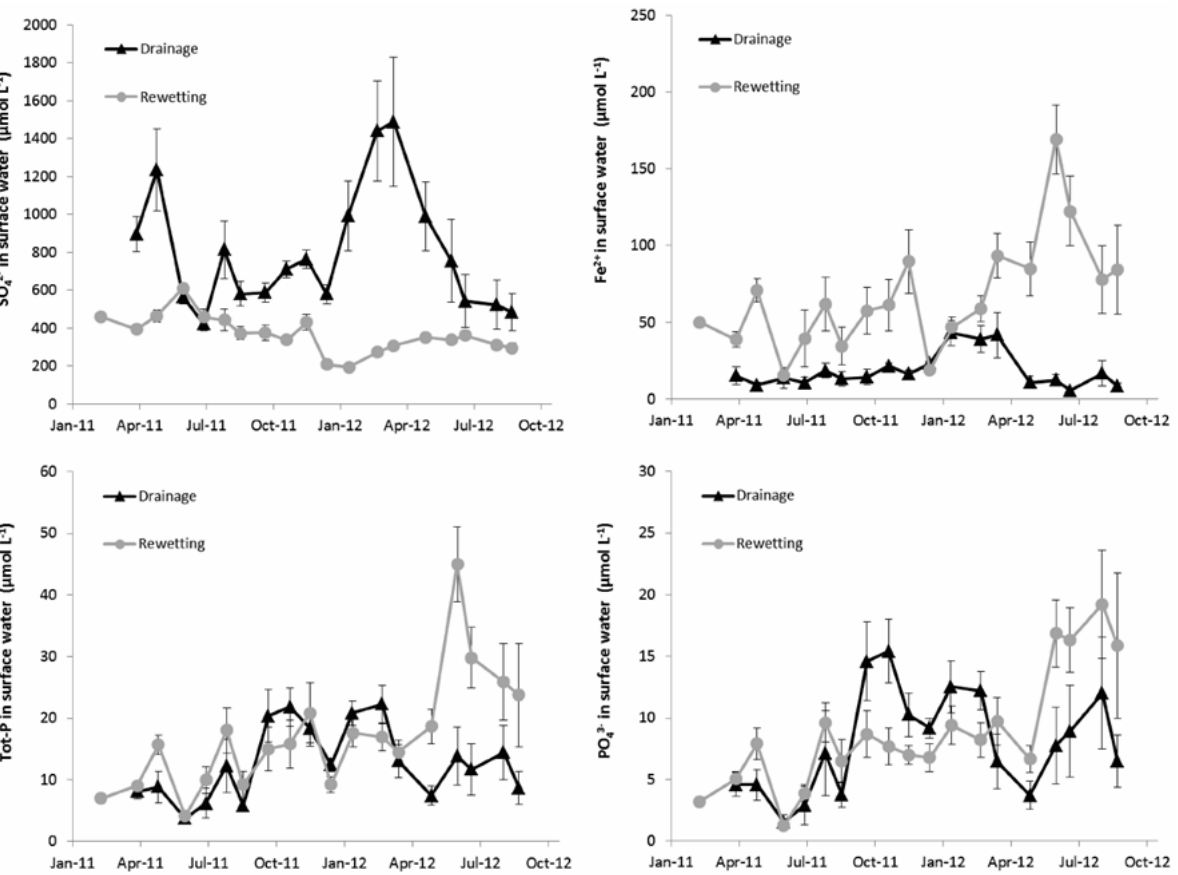
Figure 3. Average sulphate (SO 42- ), iron (Fe 2+ ), phosphor (tot-P), and phosphate (PO 43- ) concentrations monitored during 2 years in the surface water of canals, adjacent to rewetted (grey line; n=2) and still drained (black line; n=2) peatland meadows in Ronde Hoep, The Netherlands (from: van Diggelen